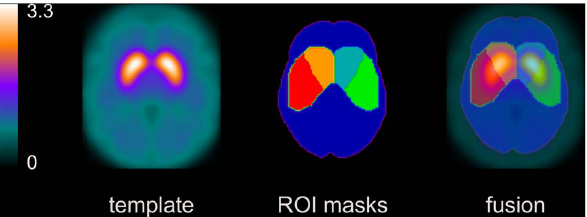
Figure 1. Custom-made I-123-ioflupane template. Transversal slice ( left ). ROIs for left/right caudate and putamen used for hottest voxel analysis, and ROI for the reference region used for intensity scaling, all defined in MNI space ( middle ). The union of caudate and putamen ROI was used as ROI for the whole striatum. Fusion image ( right